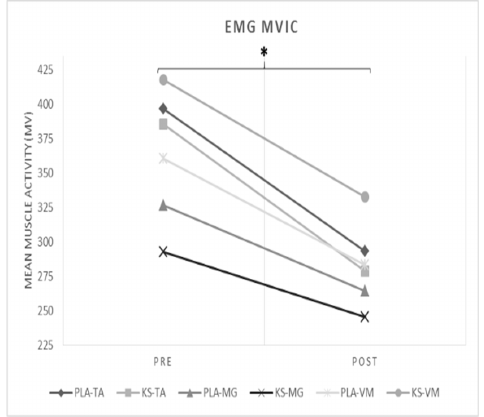
Figure 2. Mean EMG muscle activity during maximal voluntary isometric contractions (MVIC) before (PRE) and after (POST) the treadmill workload in firefighters. Groups: Placebo (PLA) and Ketone (KS). Muscles: Tibialis anterior (TA), medial gastrocnemius (MG) and vastus medialis (VM). * represents significant difference for all muscles and for both groups between PRE and POST at p < 0.05.